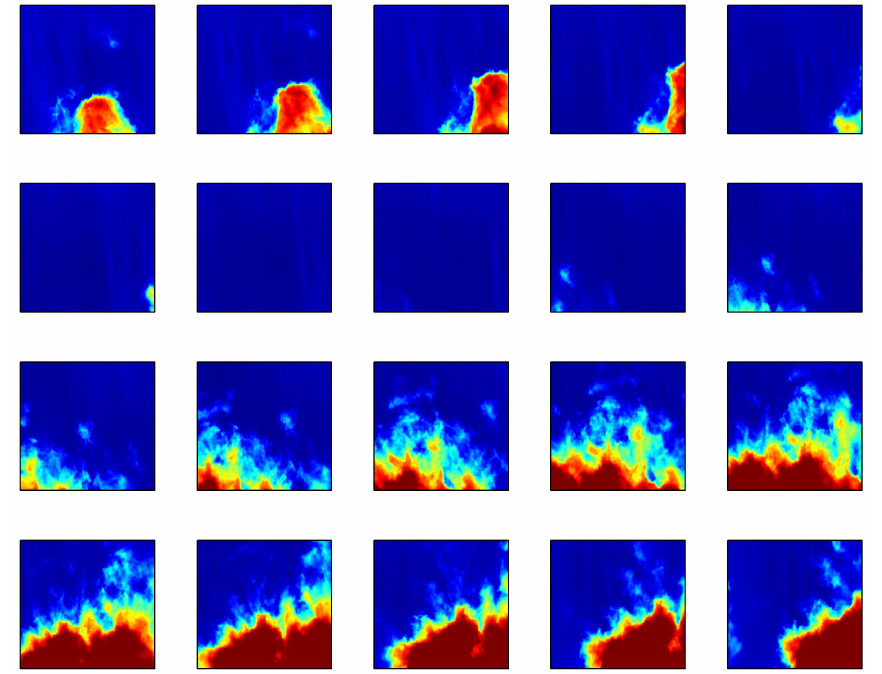
Fig. 2. A series of 20 successive IR images starting at 16 March 2010 11:31:19UTC. Time lag between images is 10s and the color-bar scale is between − 35 ◦ C (blue) to 0 ◦ C (red).